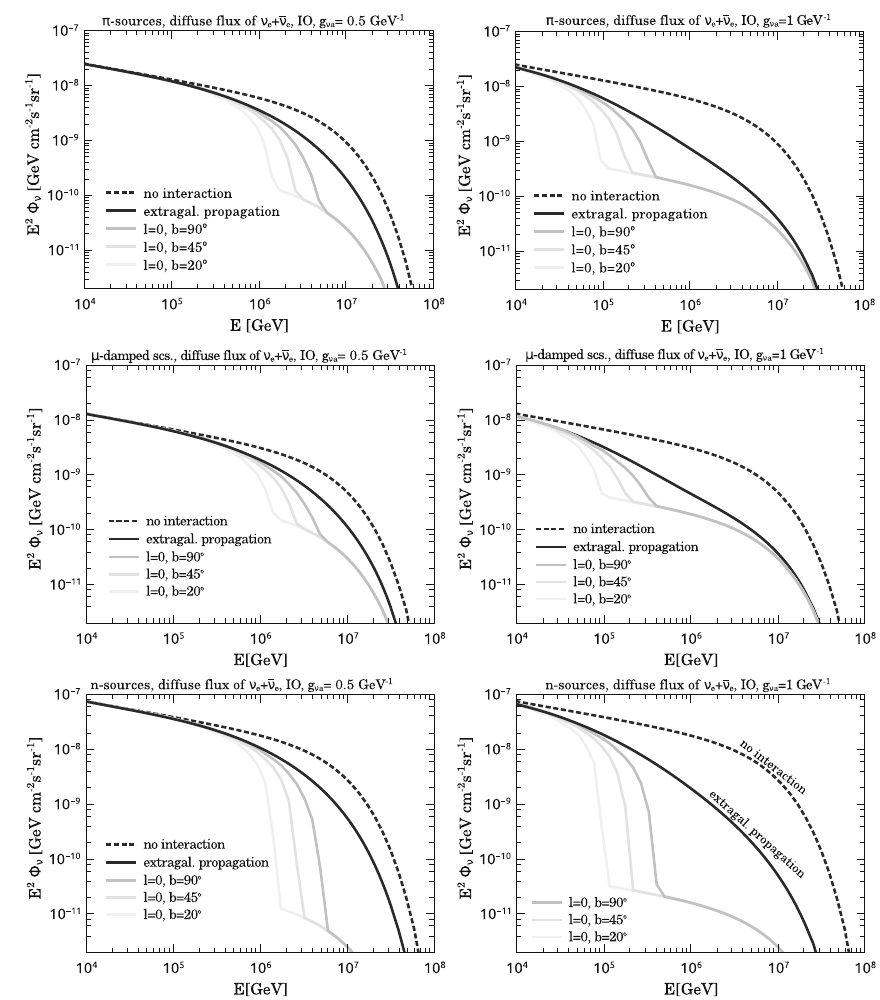
Fig. 6 Diffuse fluxes of ν e + ¯ ν e assuming an inverted order for the neutrino masses, for g ν a = 0 . 5GeV − 1 and g ν a = 1GeV − 1 in the left and right panels, respectively. Top panels correspond to pion decay sources, middle panels to muon damped sources, and bottom panels to neutron decay sources. The flux corresponding to interactions with extragalactic DM only is indicated with a black solid line in each panel, and the fluxes for the arrival directions given by l = 0 ◦ and b = { 90 ◦ , 45 ◦ , 0 ◦ } are marked with curves in dark gray, gray, and light gray,